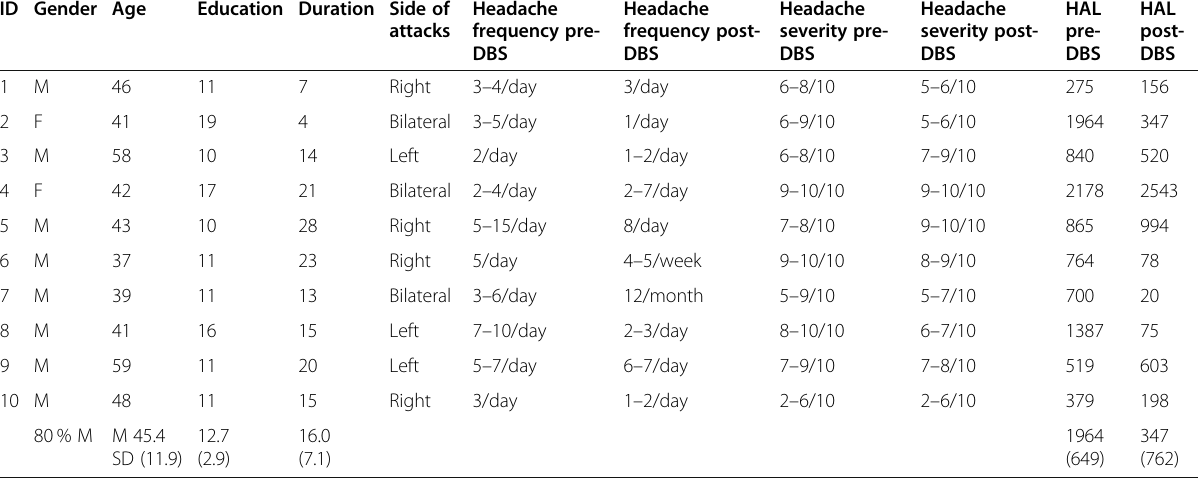
Table 1 Demographic and headache characteristics. M = male, F = female, HAL = headache load, DBS = deep brain stimulation, M = mean, SD = standard deviation. Age, education and duration units are years.